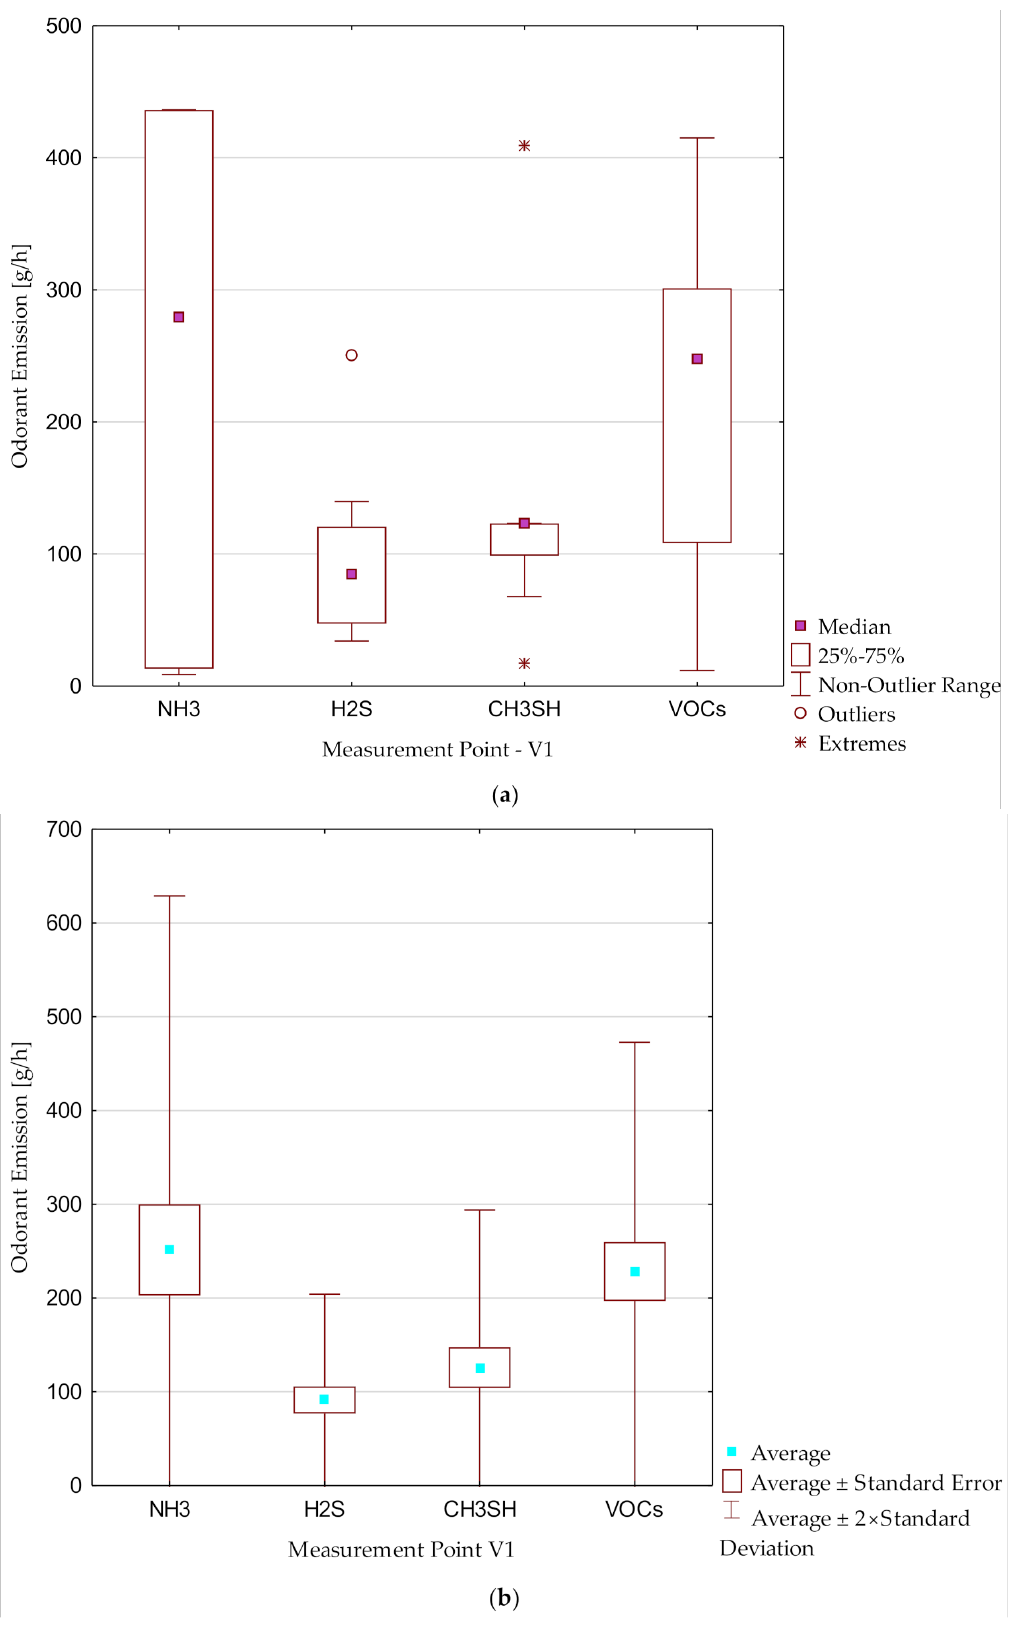
Figure 3. Odorant emission levels with median ( a ) and average ( b ) values at the first point (above the mixed waste) in every measurement